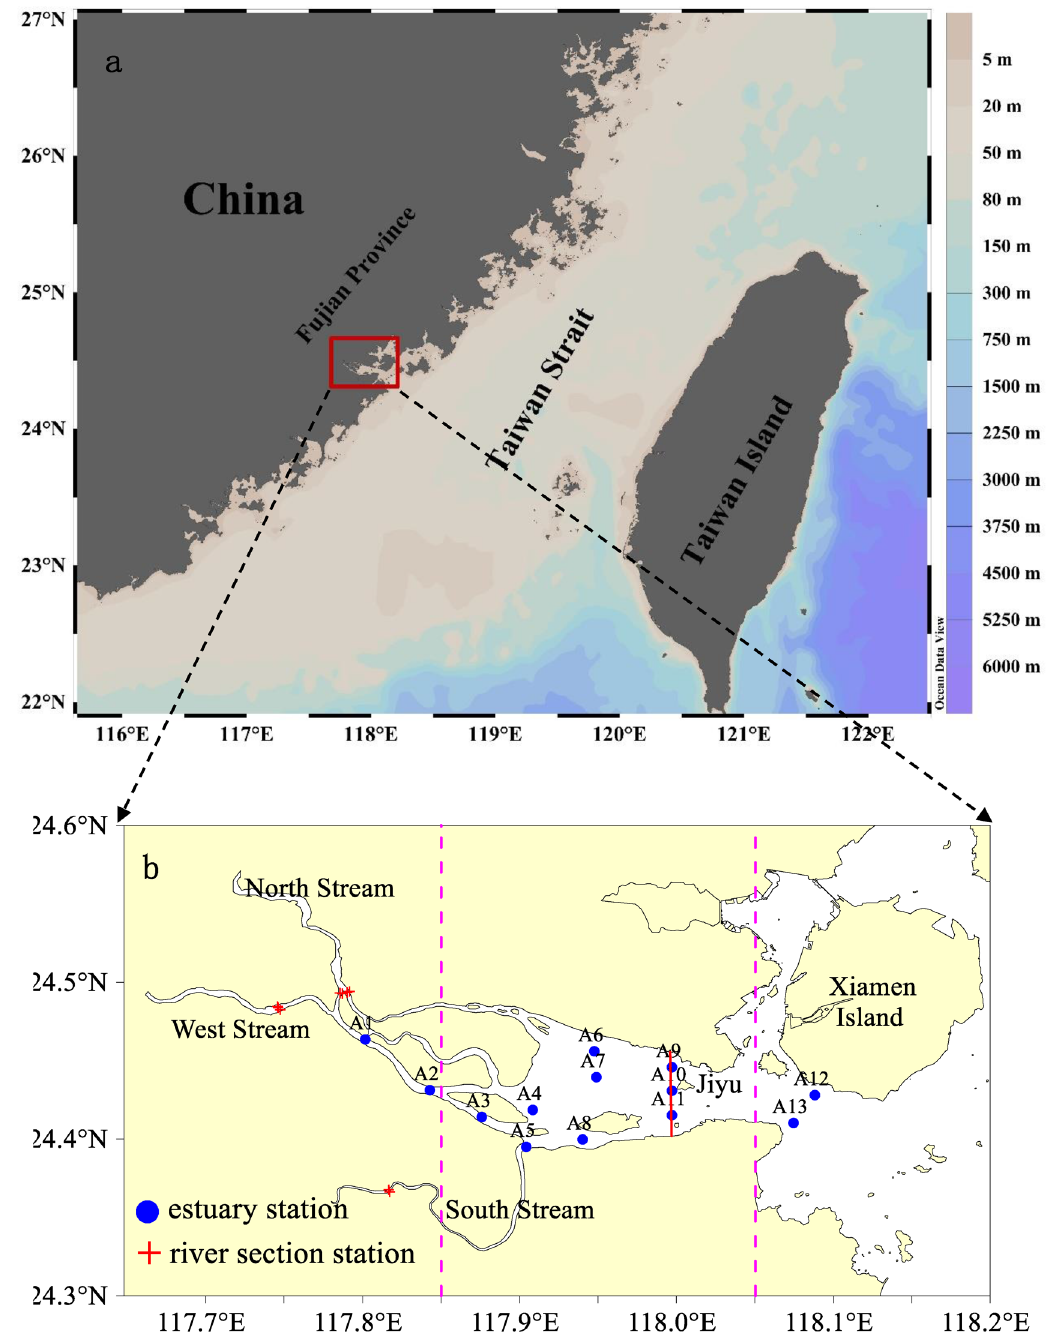
Figure 1. Maps of the ( a ) investigated area and ( b ) sampling stations in the Jiulong River Estuary (JRE). The satellite imagery in figure ( a ) was obtained from and drawn using the free software Ocean Data View (ODV 5.1.2) (Schlitzer, Reiner, Ocean Data View, https:// odv. awi. de, 2018); figure ( b ) was created with Surfer, Version 10 (https:// www. golde nsoft ware. com/ produ cts/ surfer). Red dotted lines indicate the rough boundaries of the upper, middle, and lower reaches of the